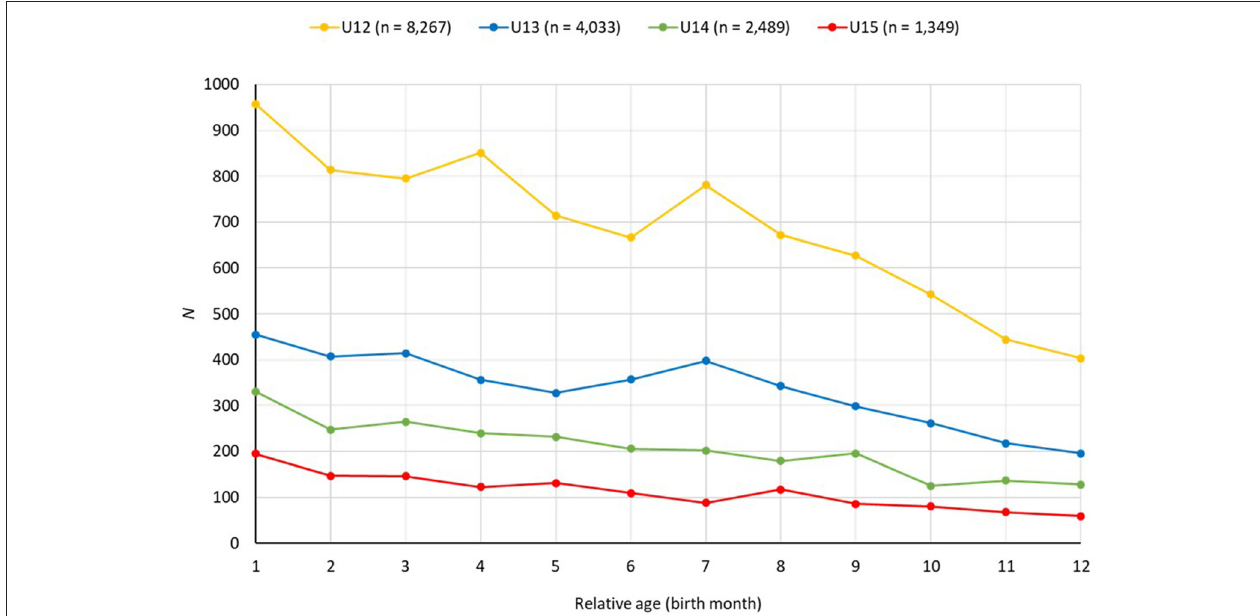
FIGURE 1 | Birth distribution of players in the age groups U12 to U15 according to their relative age (birth